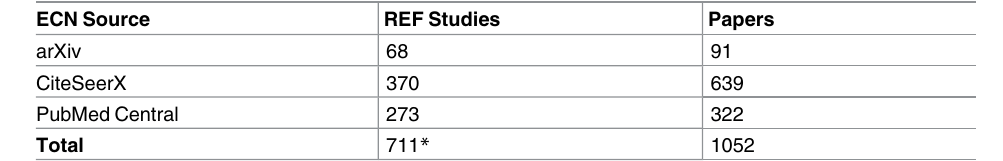
Table 1. Links from REF studies to